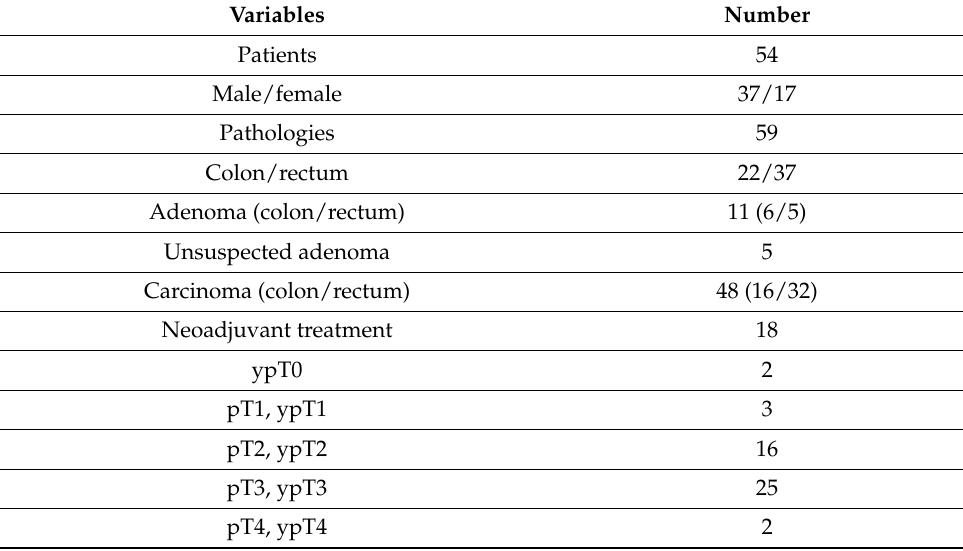
Table 1. Patient and tumor characteristics.